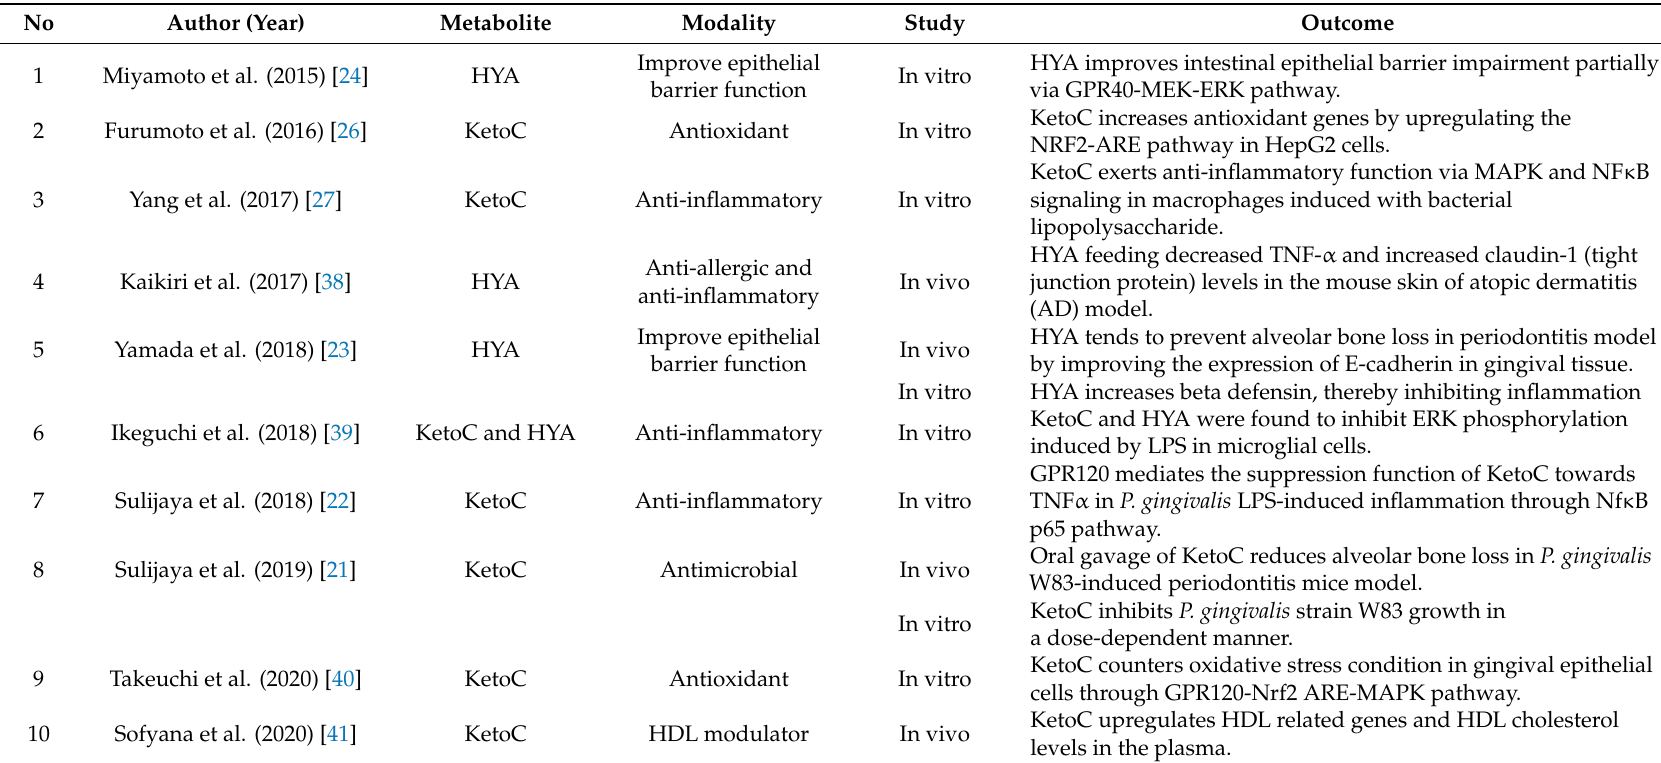
Table 1. Studies of gut metabolite in relation to periodontal